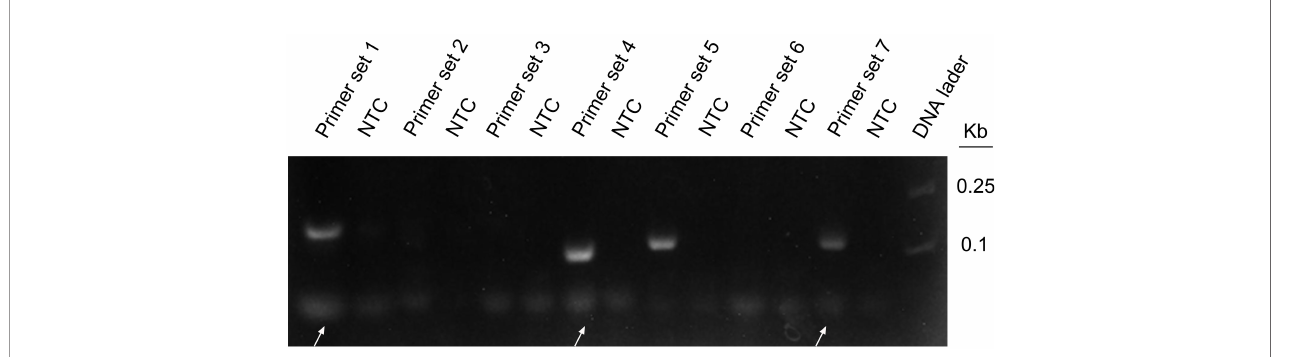
FIGURE 3 | RPA ampli fi cation combined with agarose gel electrophoresis for preliminary primer screening; 1 µl of 2 × 10 9 copies/ml was used as the template for the reaction. Lanes 1, 3, 5, 7, 9, 11, and 13 represent 7 different primer combinations. Lane NTC represents the negative control without template DNA in the left lane. White arrows represent the primer dimers. The primer names are shown at the top of each band.